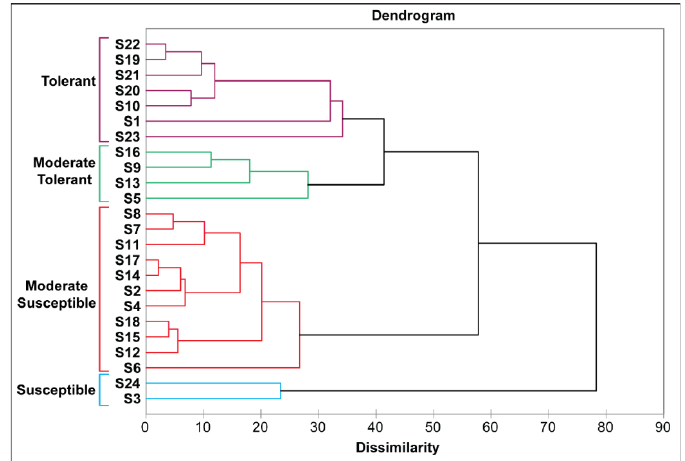
Figure 7. Grouping of 24 rice genotypes on the bases of their performance under salt stress condi- tions in glasshouse and field conditions. Four main groups light blue (susceptible); red (moderate- susceptible); light green (moderate-tolerant); and purple (tolerant) were created.